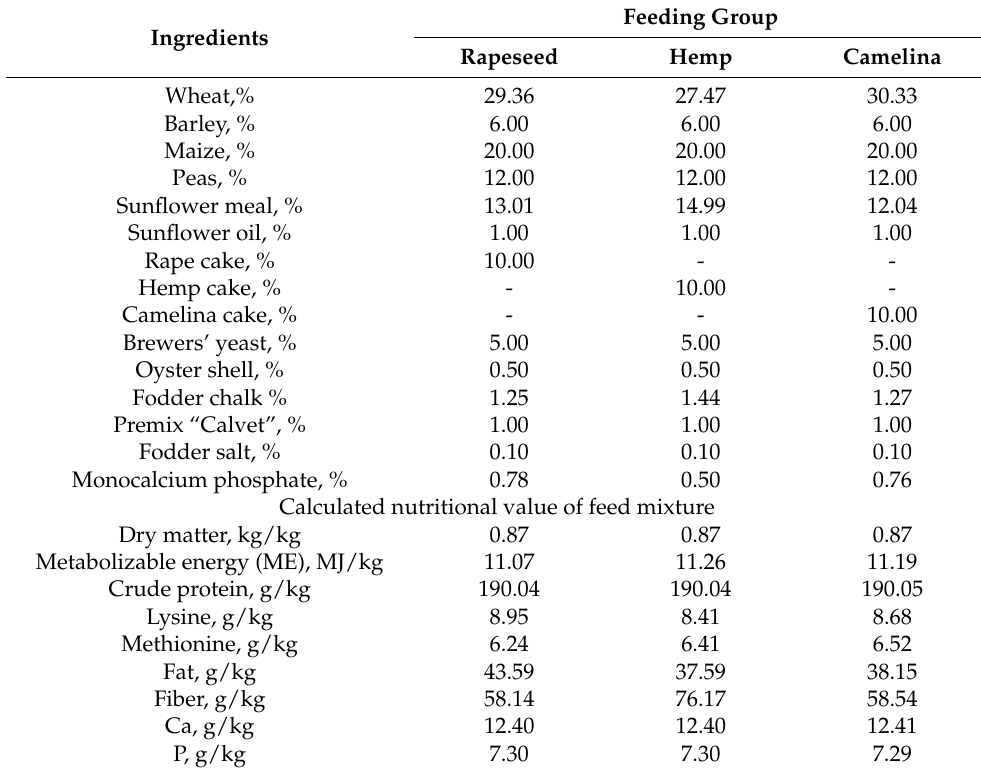
Table 1. Composition of laying quail feed and its nutritive